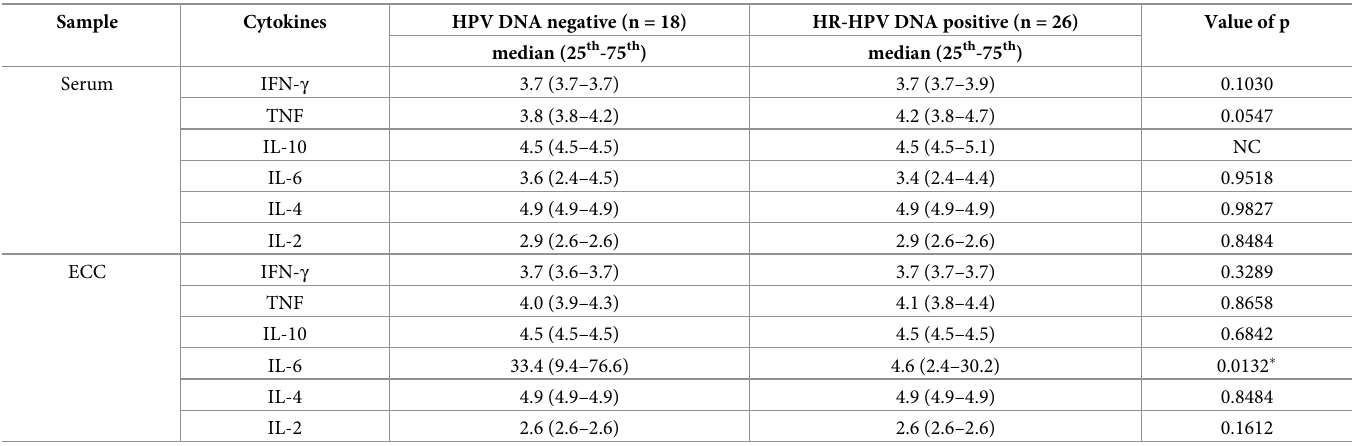
The levels of cytokines IFN- γ , TNF- α , IL-10, IL-6, IL-4, and IL-2 were quantified (pg/mL) in the serum and ECCs of 26 patients positive for HR-HPV DNA (mean age: 44.7 years) and 18 patients negative for HPV DNA (mean age: 43.6 years) as shown in the Supporting Informa- tion–Cytokine levels (DOI 10.6084/m9.figshare.13550510). The comparison of cytokine levels in the ECCs and serum of patients positive for HR-HPV revealed a significantly higher concentration of IL-6 in ECCs (p = 0.0135) and IL-10 in the serum (p = 0.0298). The differences in the concentrations of other cytokines were not signifi- cant (Table 2). To verify whether HPV influences cytokine secretion, the serum and ECC levels of cytokines were compared between HR-HPV-positive and HPV-negative patients. No signif- icant differences were observed in the blood cytokine levels between the two groups (Table 3). However, IL-6 levels were higher in the ECC samples from HPV-negative patients (p = 0.0132) (Table 3). To investigate whether a simple infection (by a single viral genotype) or multiple infections (by more than one viral genotype) influences the cytokine profile in the serum and ECCs, the Table 3. Cytokine levels in the Exfoliated Cervical Cells (ECC) and serum of HR-HPV DNA-positive and HR-HPV DNA-negative patients.